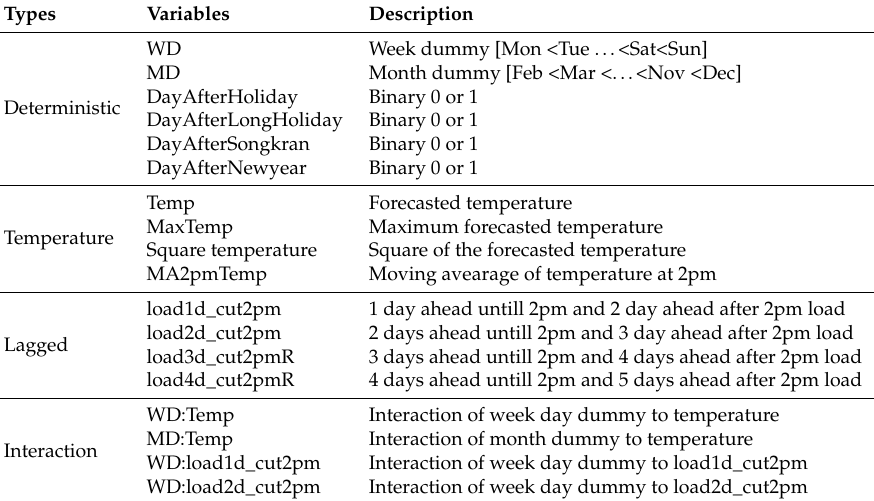
Table A1. List of selected input